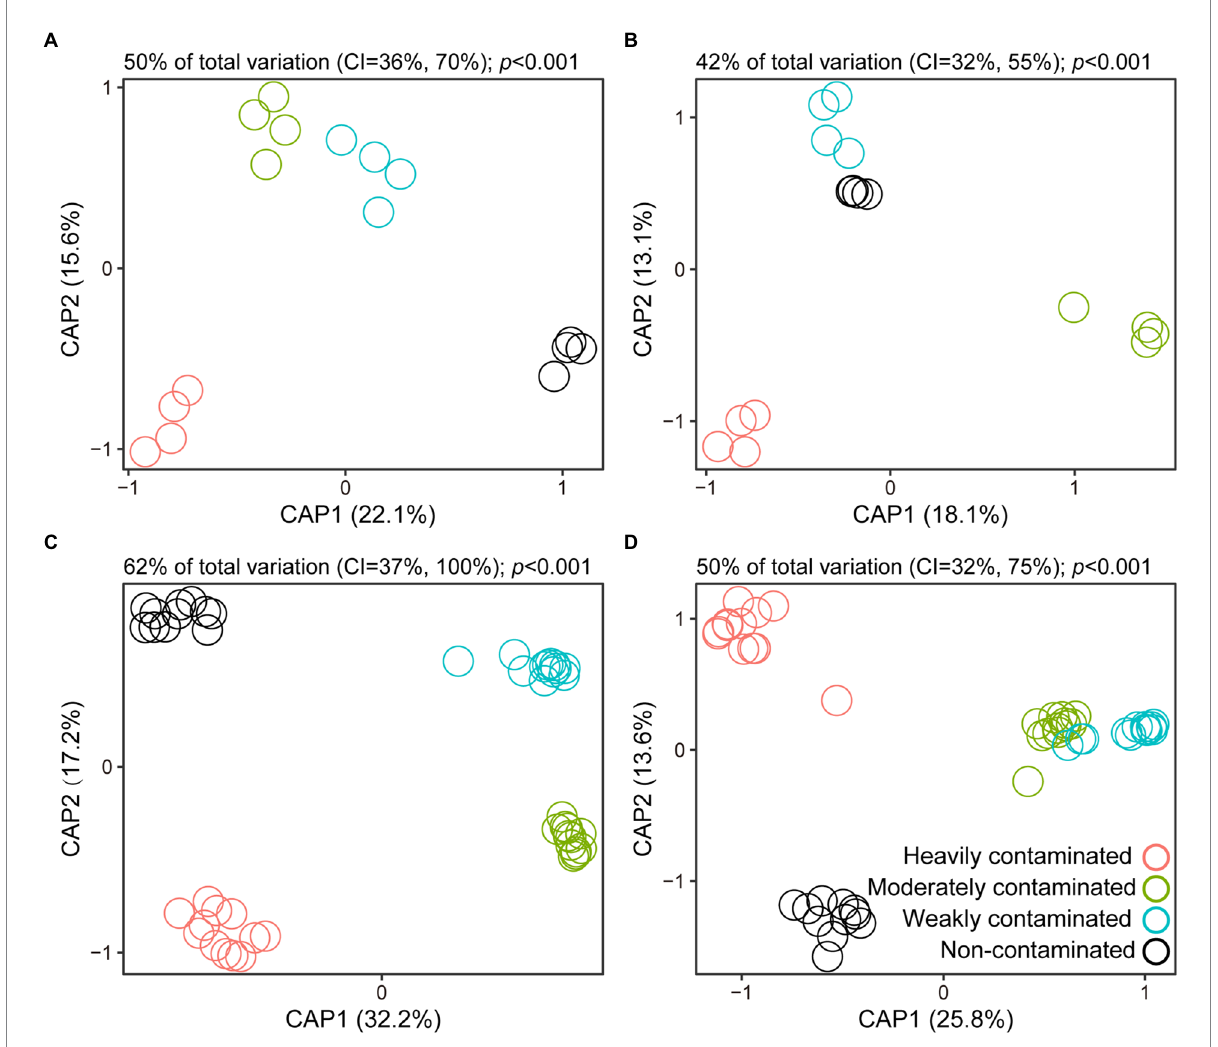
FIGURE 2 Canonical analysis of principal coordinates (CAP) based on Bray–Curtis distances for visual presentations of differences in bacterial and fungal community composition in rhizosphere soil of Pteris vittata sampled in field (A,B) and pot (C,D) experiments. Open circles in different colors represent soil samples with different arsenic contamination